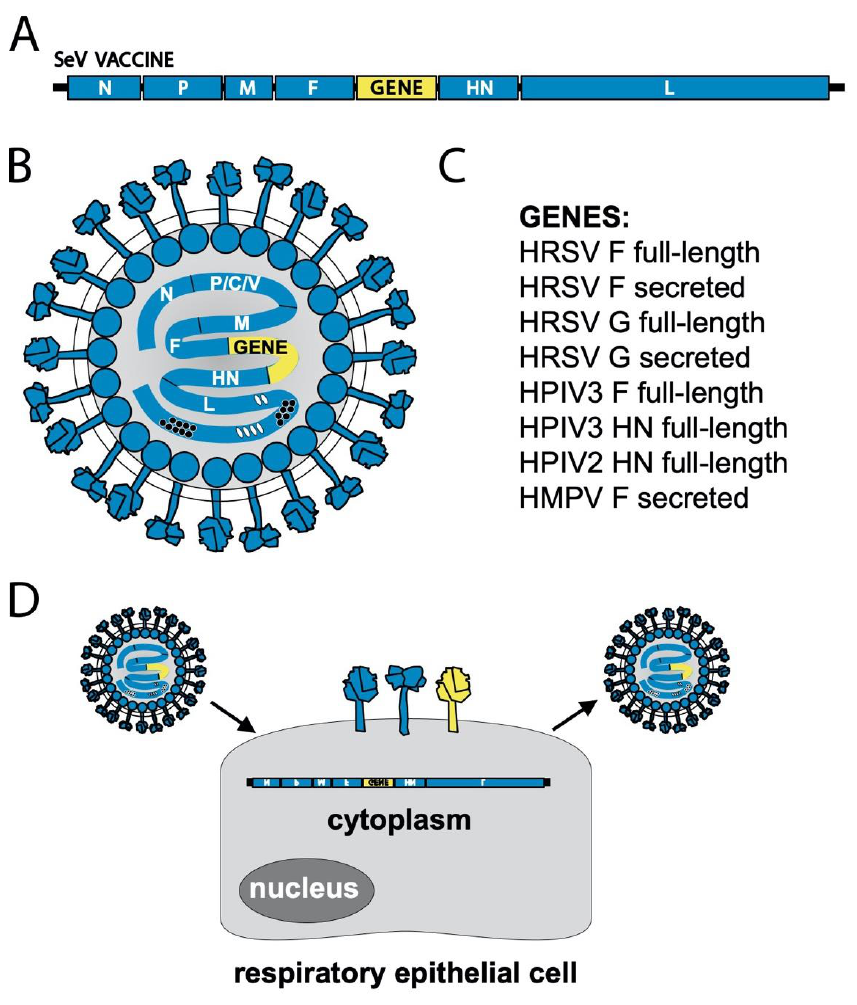
Figure 6. Schematic of gene delivery by SeV-vectored vaccines. ( A ) SeV vector genome structure. SeV genes are colored blue, and a foreign gene is colored yellow. Most SeV-vectored vaccines have been constructed with the inserted gene positioned between the F and HN genes, which allows for sufficient vaccine antigen expression while causing little to no attenuation of replication. ( B ) SeV virion structure. Vaccine is composed of SeV proteins (blue), SeV genome (blue), and a foreign gene (yellow). ( C ) List of genes inserted into SeV-vectored vaccines that have been tested in preclinical studies. (D) Schematic of vaccination. SeV-vectored vaccines are intranasally inoculated and infect respiratory epithelial cells. Replication occurs in the cytoplasm and produces both the foreign gene product (yellow) and SeV genes and genome (blue). New progeny virions are generated, but SeV replication is attenuated in species other than mice because its accessory genes are only able to counteract interferon responses in mice.